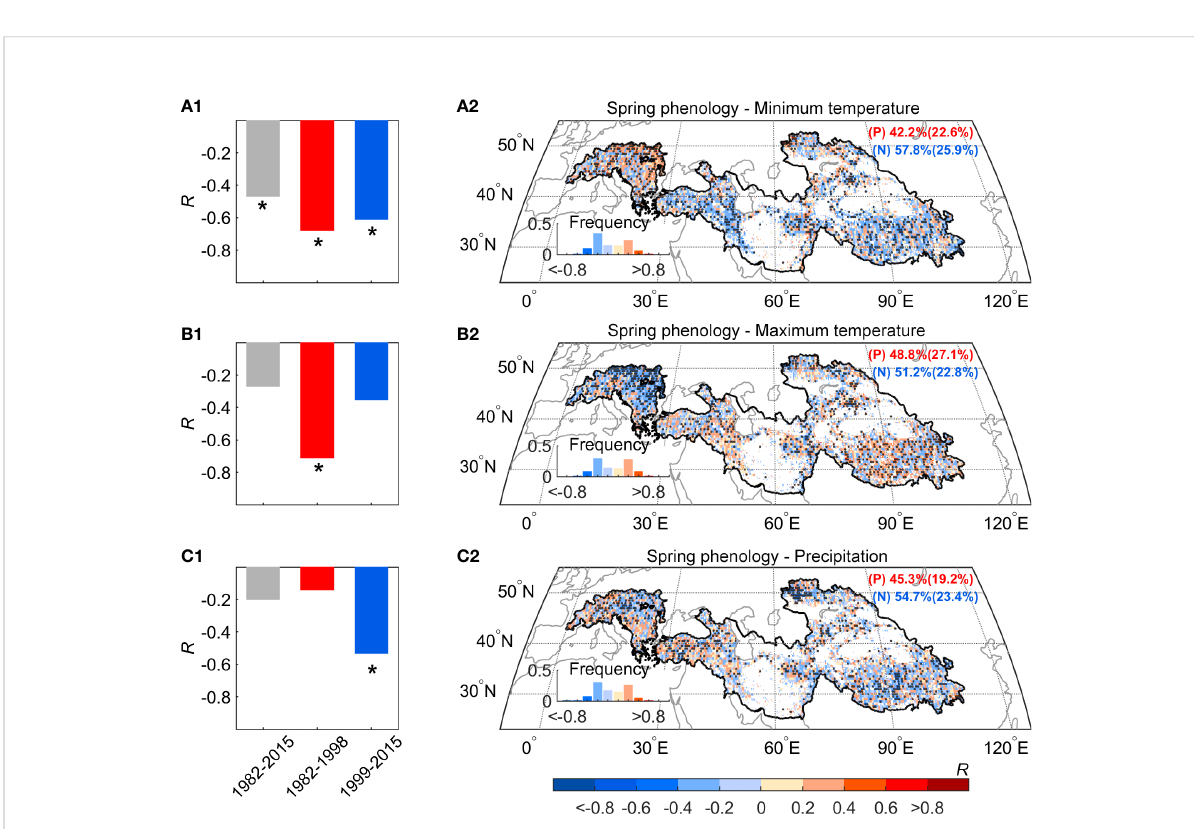
FIGURE 5 The relationship of the spring phenology with preseason Tmax, Tmin, and Precipitation during 1982 – 2015 over the Pan-Third Pole. Partial- correlation coef fi cients ( R ) between preseason Tmin (A) , Tmax (B) precipitation (C) after controlling for other factors. Here we also controlled insolation in the analysis. The dots indicate the regions with signi fi cant correlation coef fi cients ( P< 0.05) and the asterisk indicate the regions with a signi fi cant correlation (P< 0.05).